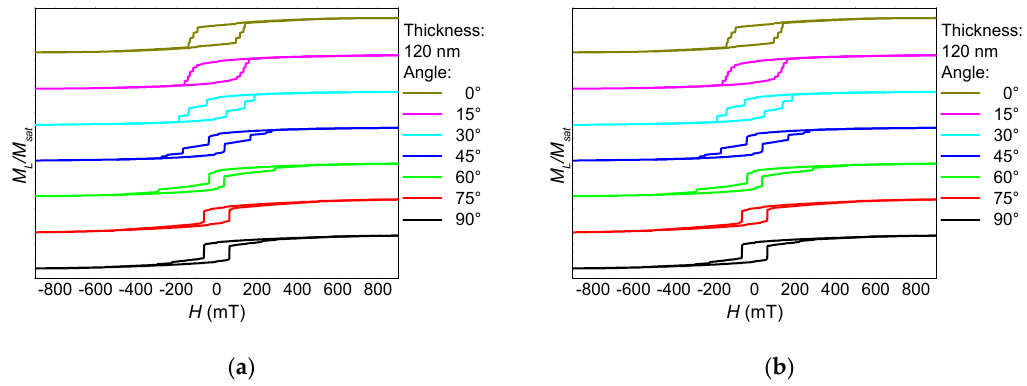
Figure 5. Angle dependence of ( a ) the longitudinal and ( b ) the transverse hysteresis loops, simulated for sample NF1 with a thickness of 120 nm.